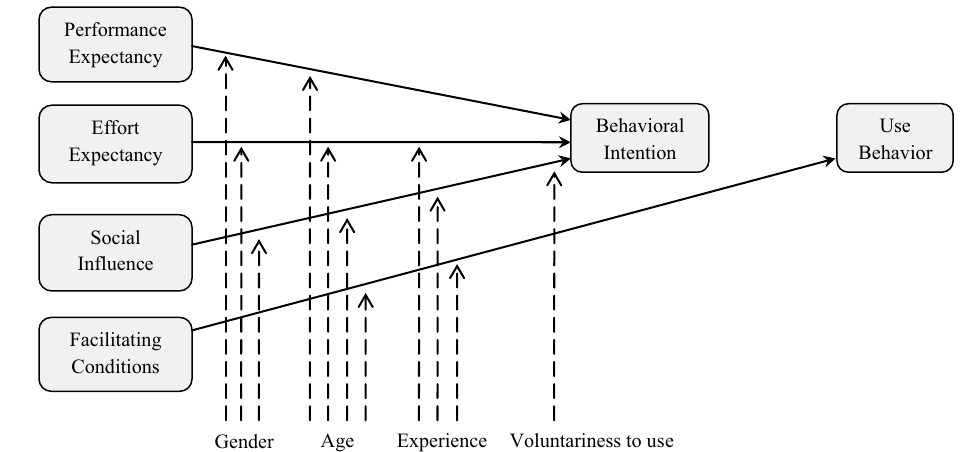
Fig. 1 Theoretical framework of UTAUT (Venkatesh et al. 2003)